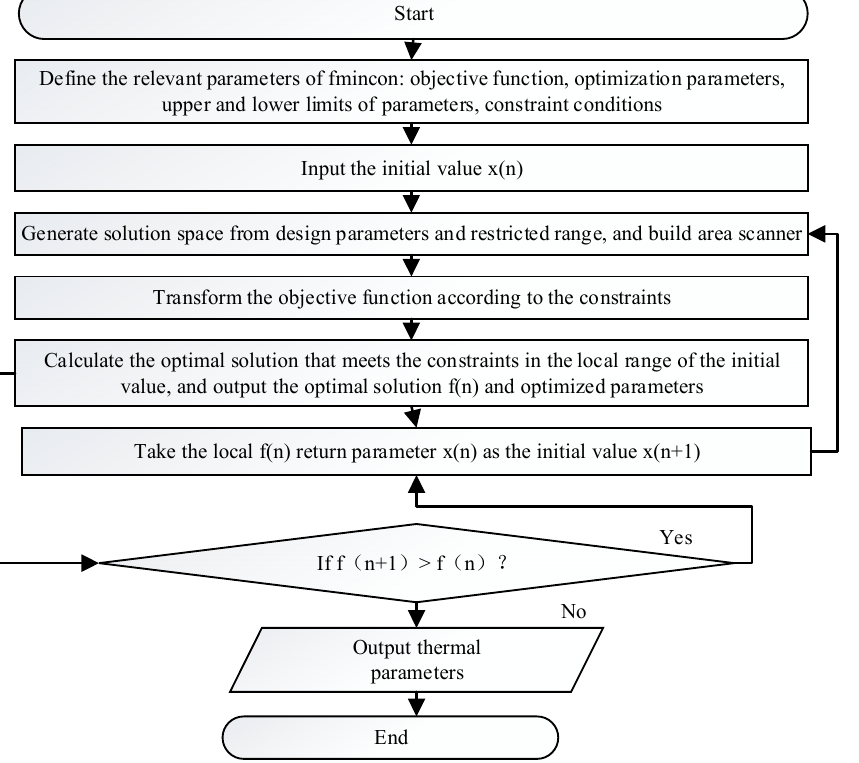
Figure 1. Flow chart of the one-dimensional optimization design.